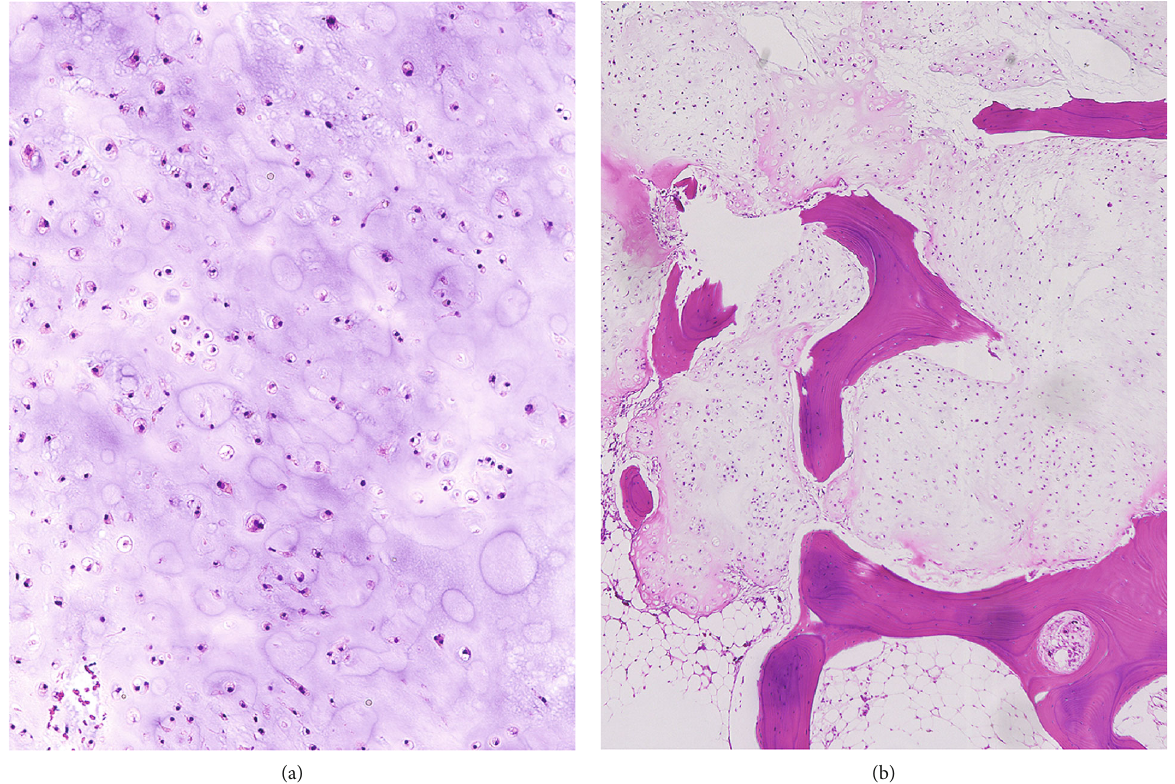
Figure 2: Grade I chondrosarcoma, moderately cellular and containing hyperchromatic, plump nuclei of uniform size (a). In fi ltration through the marrow cavity with a “ permeation pattern ” is seen